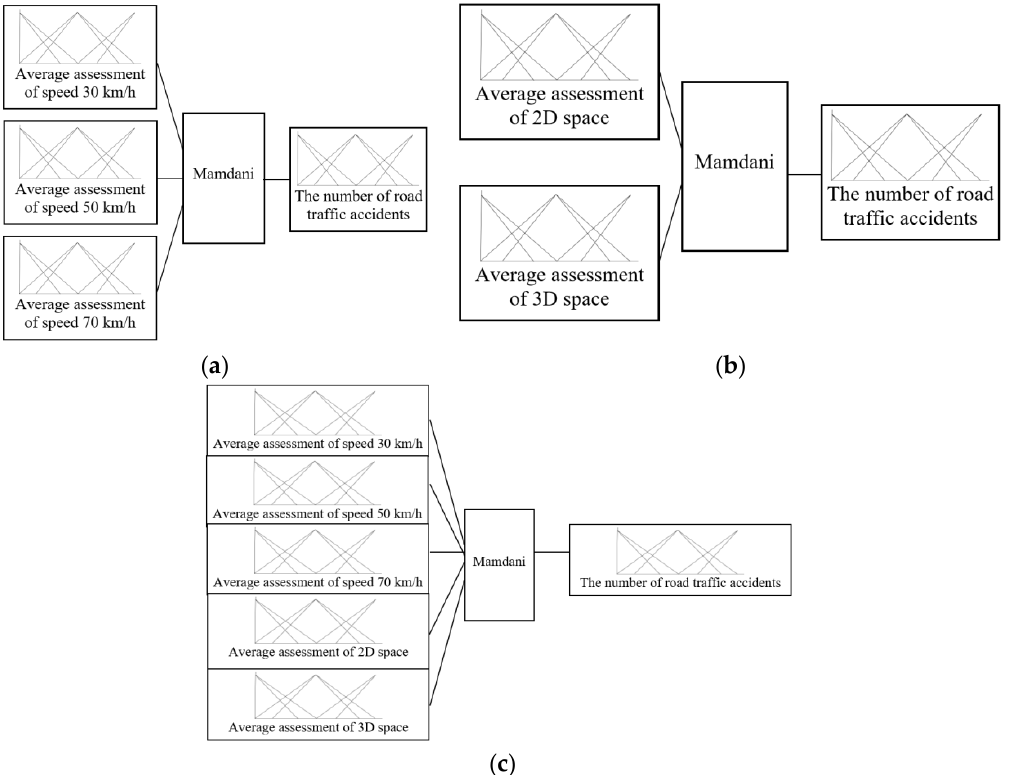
Figure 4. Configuration of the research: ( a ) the model of speed assessment capabilities— T2FIS_speed ; ( b ) the model of space assessment capabilities— T2FIS_space ; ( c ) the model that encompasses all considered input variables— T2FIS_speed_and_space .